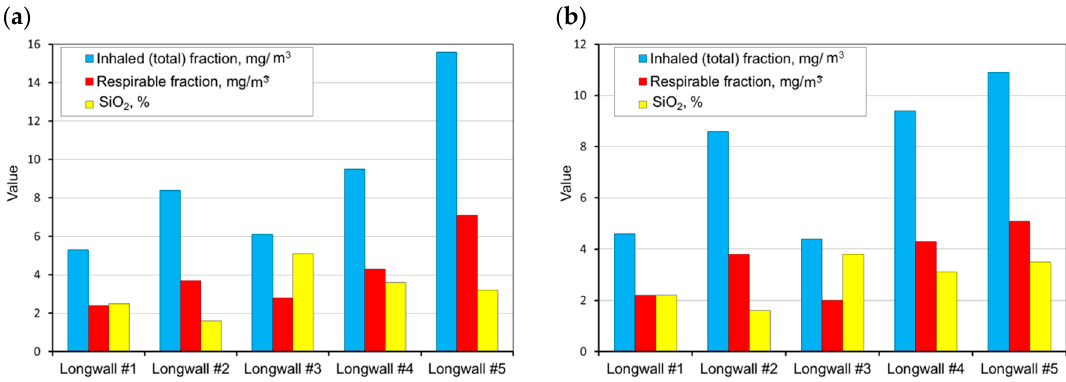
Figure 7. The measurement results for the dust levels in the positions of the miner working at a distance of 20 to 40 m from the shearer from the side of the air inlet into the longwall ( a ) and the miner operating the scraper conveyor ( b ) (workplaces 5 and 7).